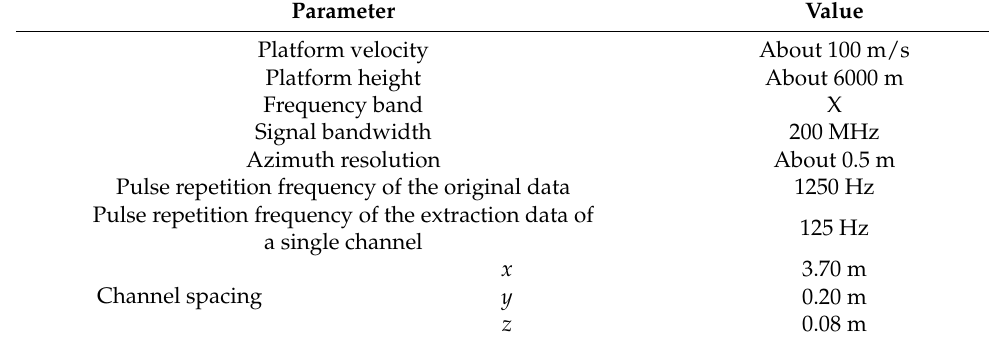
Table 3. Airborne dual-channel SAR experiment system parameters.